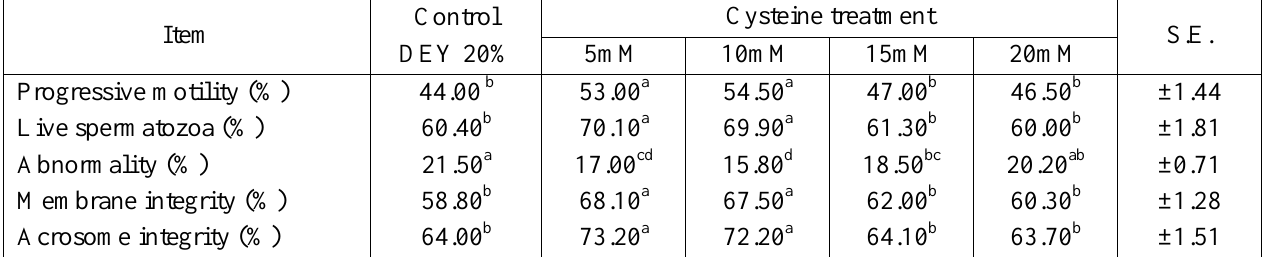
Table 3: Effect of different concentrations of Cysteine added to Holstein bull spermatozoa’s extender, after thawing (Mean ± S.E):